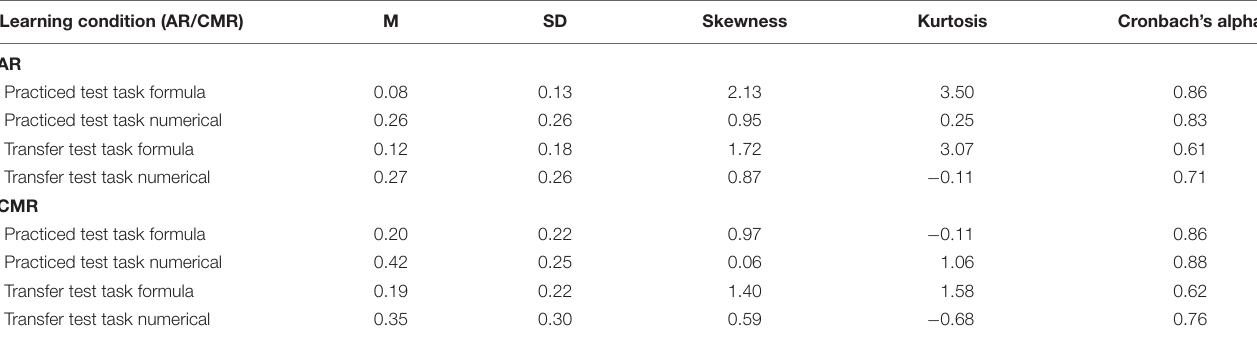
TABLE 1A | Mean proportion correct response ( M ) and standard deviations ( SD ), skewness, kurtosis and Cronbach’s alpha for the AR and CMR learning conditions, respectively. Learning condition (AR/CMR)